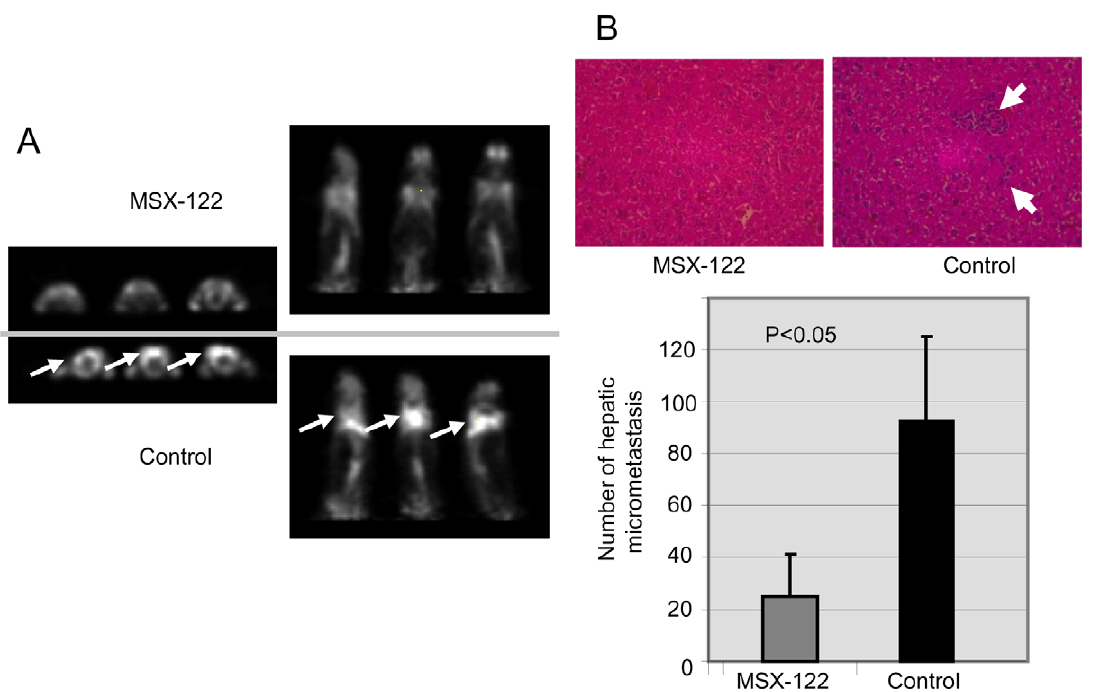
Figure 7. MSX-122 blocks metastasis in two more animal models for metastasis. (A) Non-invasive [ 18 F]FDG-PET imaging of lung metastasis in head and neck cancer animal models. Three randomly selected mice revealed lung metastases in all mice in the control group; significantly less metastasis was found in the MSX-122 (10 mg/kg i.p., daily) treated group. Left panels show the axial images of three subjects from the control group (bottom) and three from the treated group (top). Right panels show the corresponding coronal images of the same mice. White arrows indicate metastasized SCCHN tumor cells. (B) The inhibition effect of MSX-122 (10 mg/kg i.p., daily) in a uveal melanoma micrometastasis animal model. Micrometastatic clones in liver are shown by small white arrows in the images. MSX-122 significantly decreased the numbers of hepatic micrometastases.